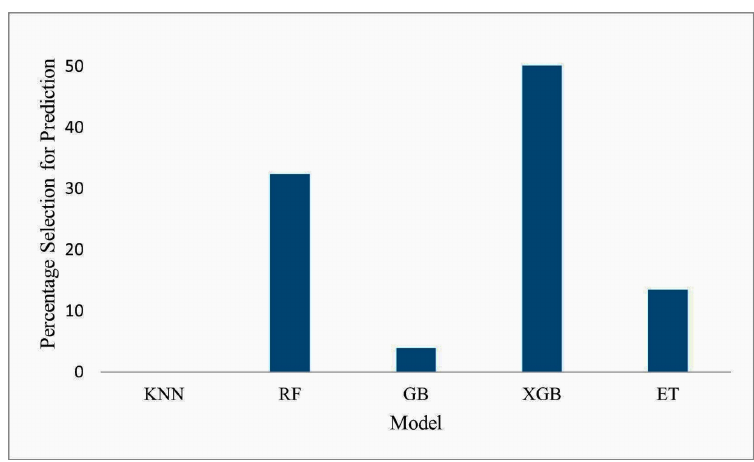
Figure 14. Percentage of model selection in DRS for dataset 2.